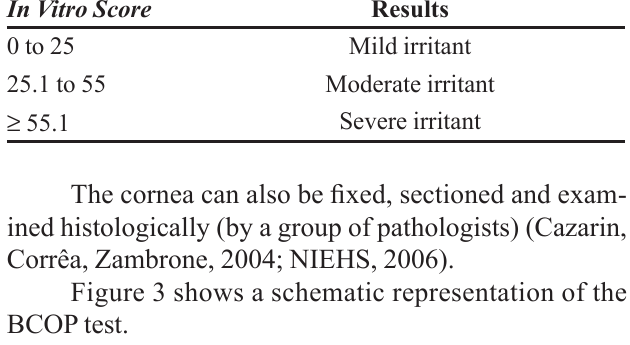
TABLE II - In vitro values for classification of irritants In Vitro